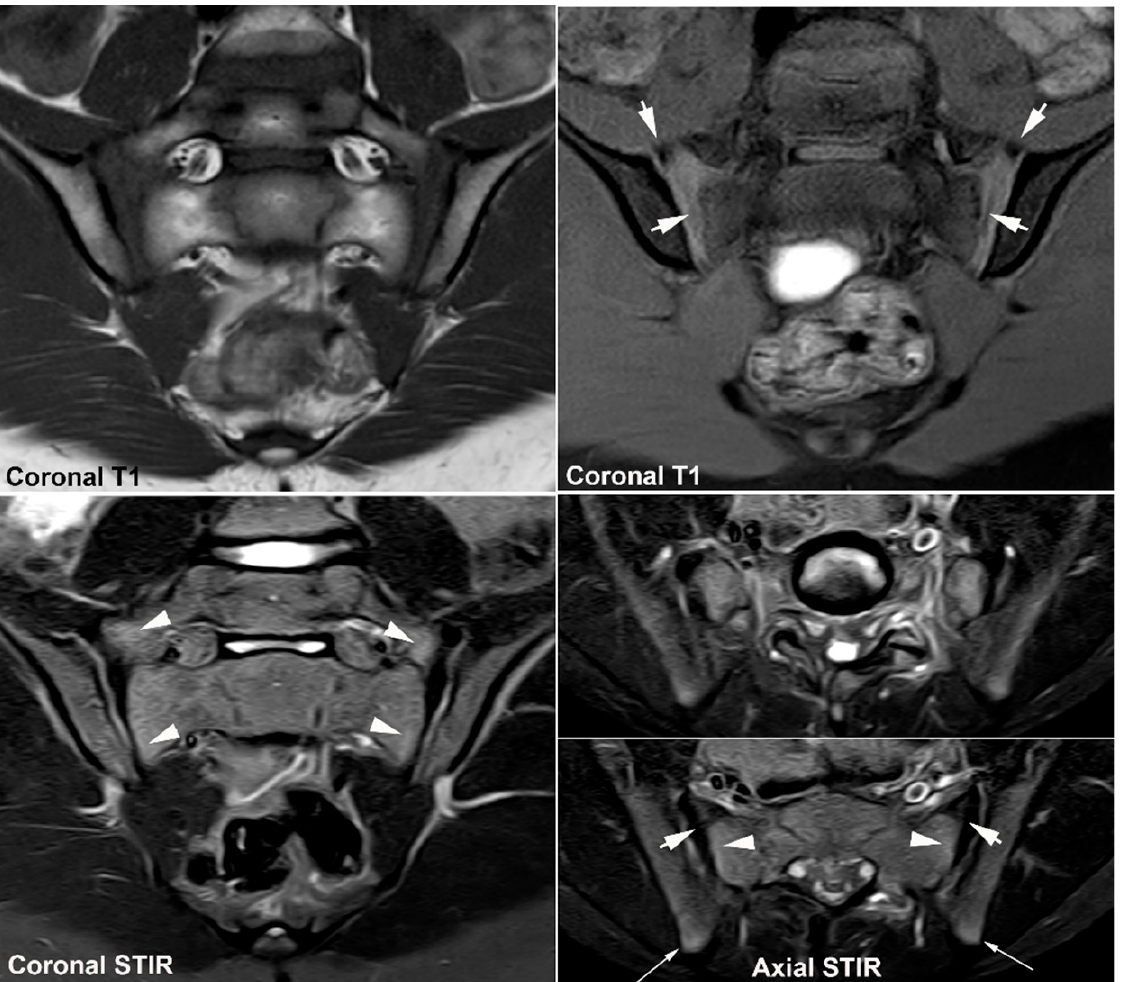
Figure 3. Normal SIJ in a 10-year-old boy. Upper row of images: semi-coronal T1 and T1FS; lower row: semi-coronal STIR and two semi-axial STIR images, superiorly at S1 (upper images) and at the border between S1 and S2, respectively. There is a brim of subchondral edema in the sacrum (arrowheads) nearly as bright as the edema at the iliac crest posteriorly (thin long arrows). Moreover, persistence of intervertebral space between S1 and S2, and visible nuclei at the sacral wings and in the joint spaces, best visualized on the T1FS image and on the axial slice at the border between S1 and S2